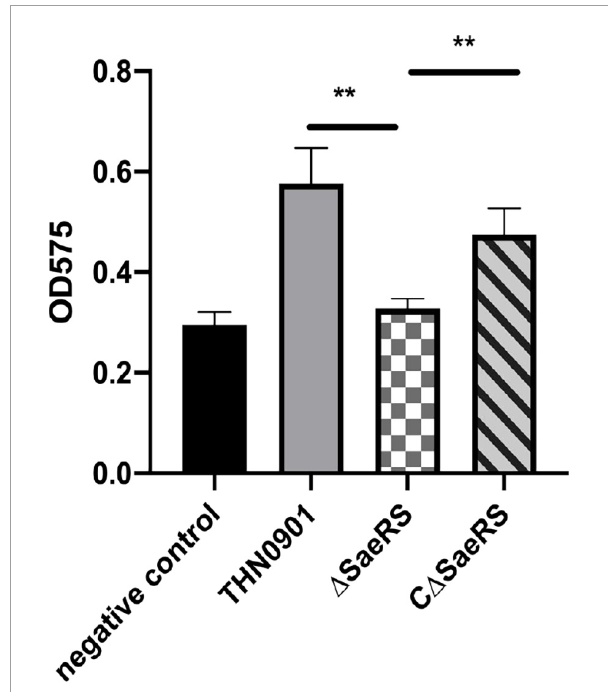
FIGURE3 Biofilm formation of three S. agalactiae strains by microtiter plate assays. Each experiment was performed in triplicate, and data were presented as mean ± standard deviation (SD), *: 0.01 < P < 0.05, **: P <